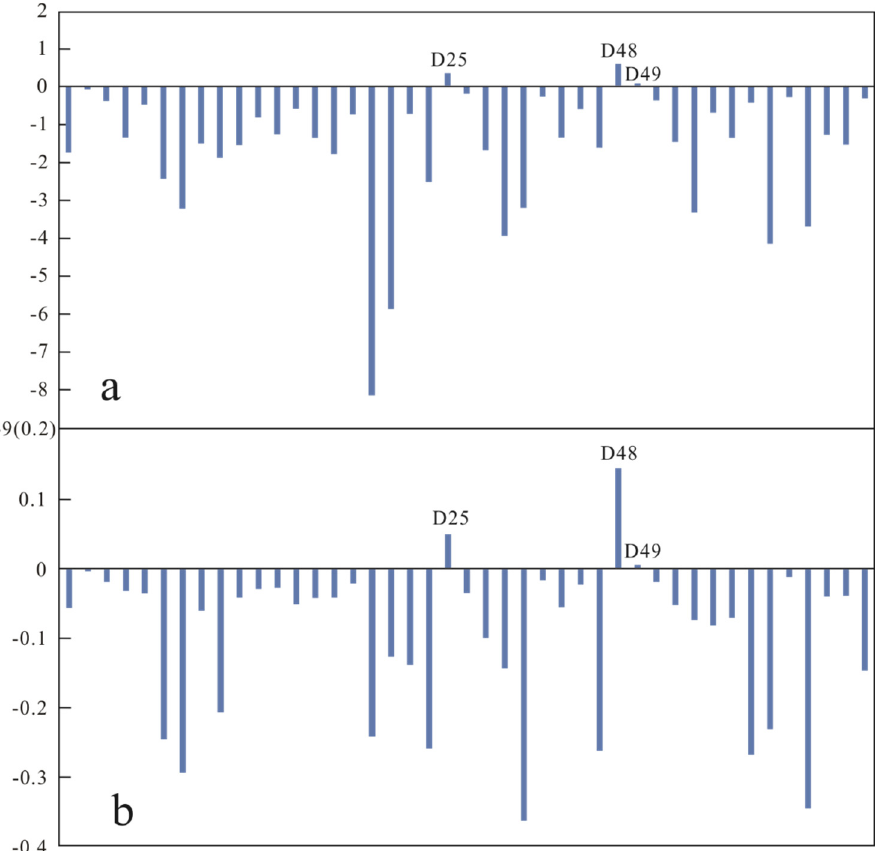
Figure 6. Cation exchange diagrams for the groundwater in the study area (( a ). The value of CAI 1 ( b ). The value of CAI 2).